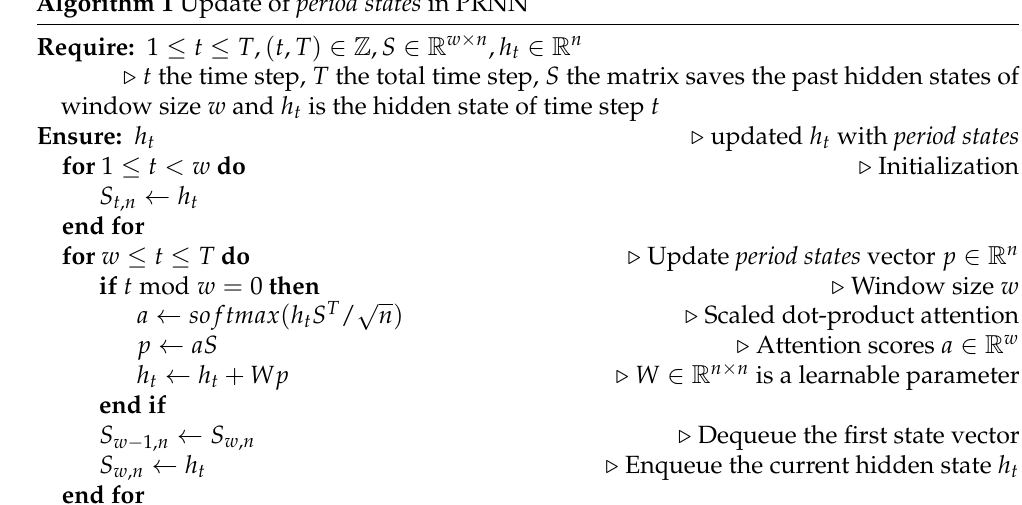
Algorithm 1 Update of period states in